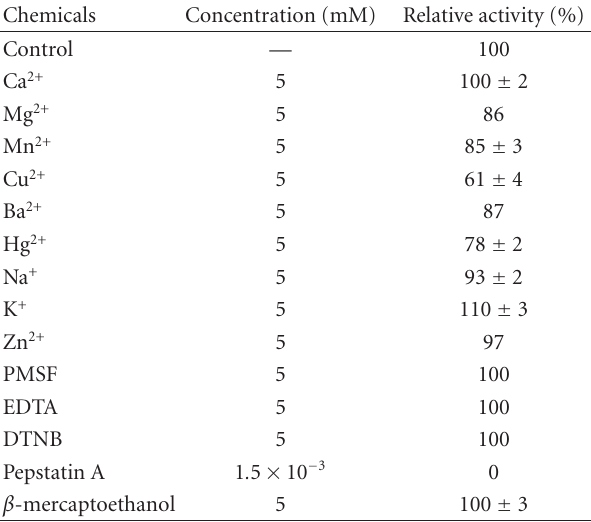
Figure 3: SDS-PAGE and zymography of A. niger I1 crude enzyme preparation. Lane 1: zymography on casein; lane 2: SDS-PAGE after staining with Coomassie blue R250; lane 3: molecular mass markers. Table 7: E ff ect of some metal ions and inhibitors on A. niger I1 protease activity.